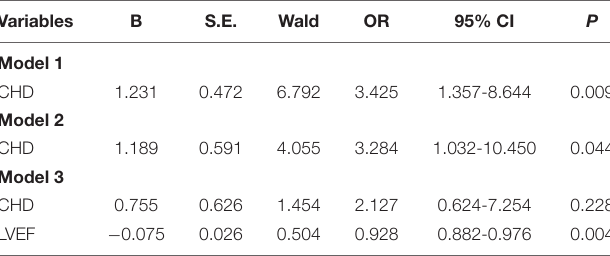
TABLE 3 | Relationship between coronary heart disease (CHD) and cognitive impairment after correcting for confounds.